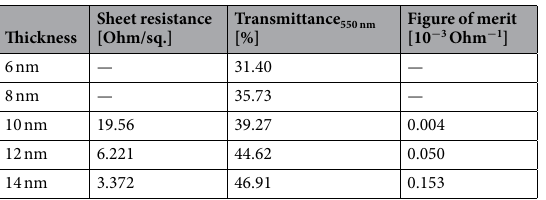
Sheet resistance [Ohm/sq.]